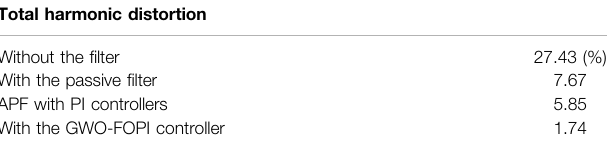
TABLE 4 | Comparison of